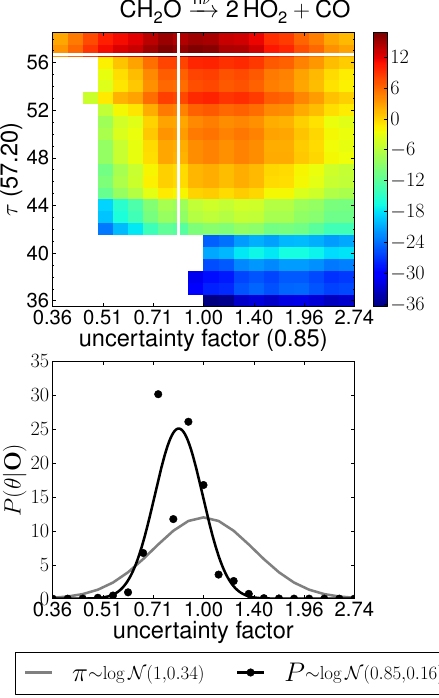
Fig. A5. Same as Fig. A1 for the CH 3 O 2 . +NO 2 → CH 3 O 2 NO 2 reaction.